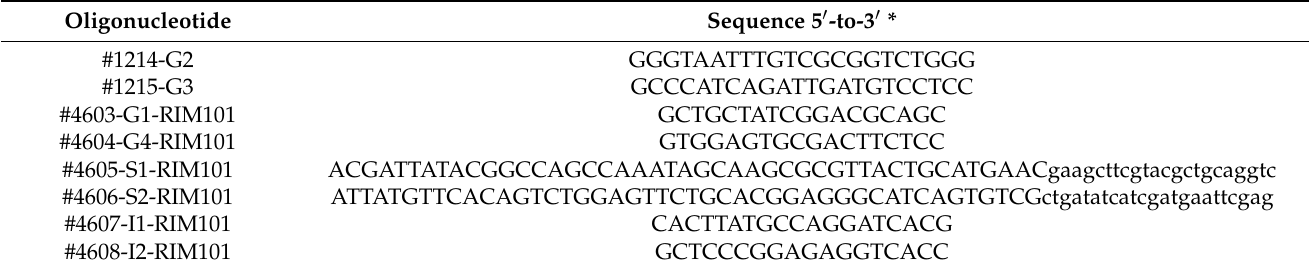
Table 2. Oligonucleotide primers used in this